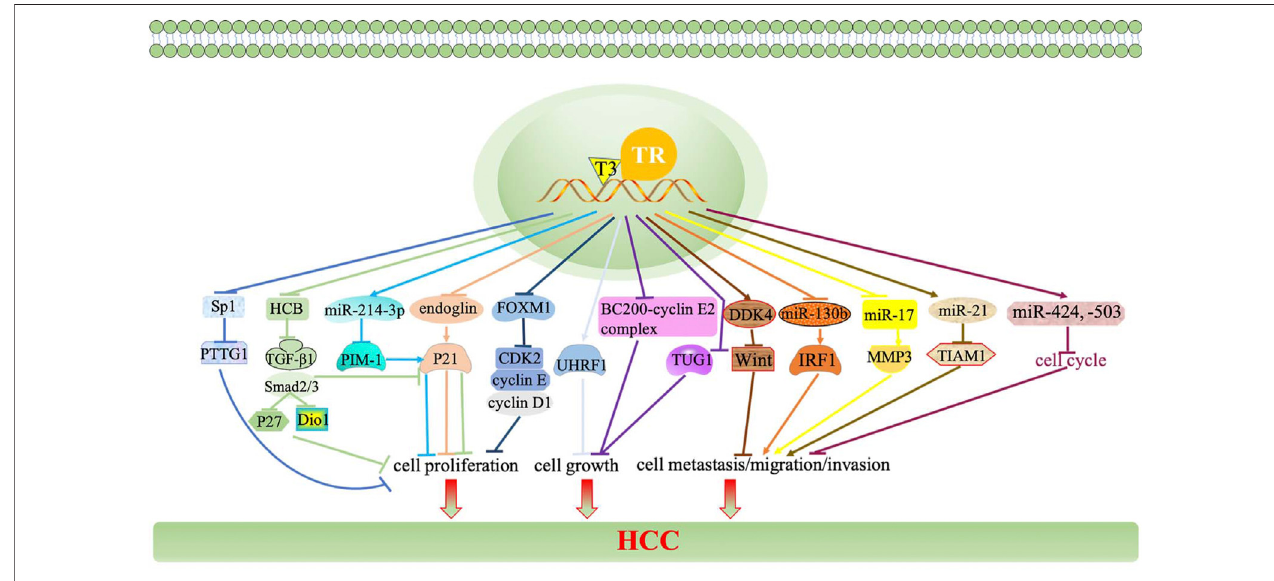
FIGURE 2 | TH/TR axis is involved in HCC growth, proliferation, invasion, and metastasis. The TH/TR axis upregulates endoglin, thus restraining P21 polyubiquitination-induced cell proliferation. The TH/TR axis inhibits hepatoma cell growth via repressing UHRF1 and relieves UHRF1-mediated P21 silence. TH induces the miR-214-3p expression, followed by interfering with PIM-1 and activating P21, thus blocking cell proliferation. The depletion of HCB by TH downregulates theTGF- β 1/pSMAD-2/3 signaling pathway, thusincreasingDio1levels anddecreasingp21 andP27,ultimately suppressing cellproliferation.Thesilence ofTGF- β micepromote theproliferationbyincreasingtheexpressionsofCDK2,cyclinE,andcyclinA,aswellasdecreasingtheexpression ofCDKn1a/p21.DepletingFOXM1by TH interferes with cyclin D1, cyclin E, and CDK2, thereby inhibiting HCC cell proliferation.